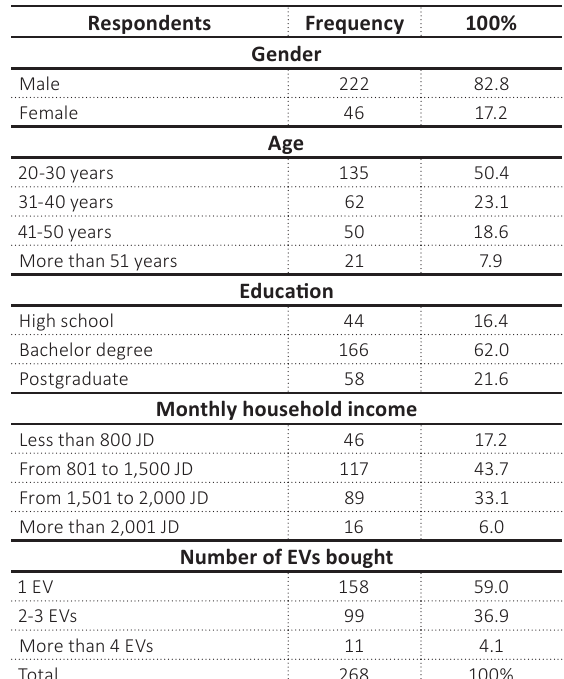
Table 1. Demographic profile of